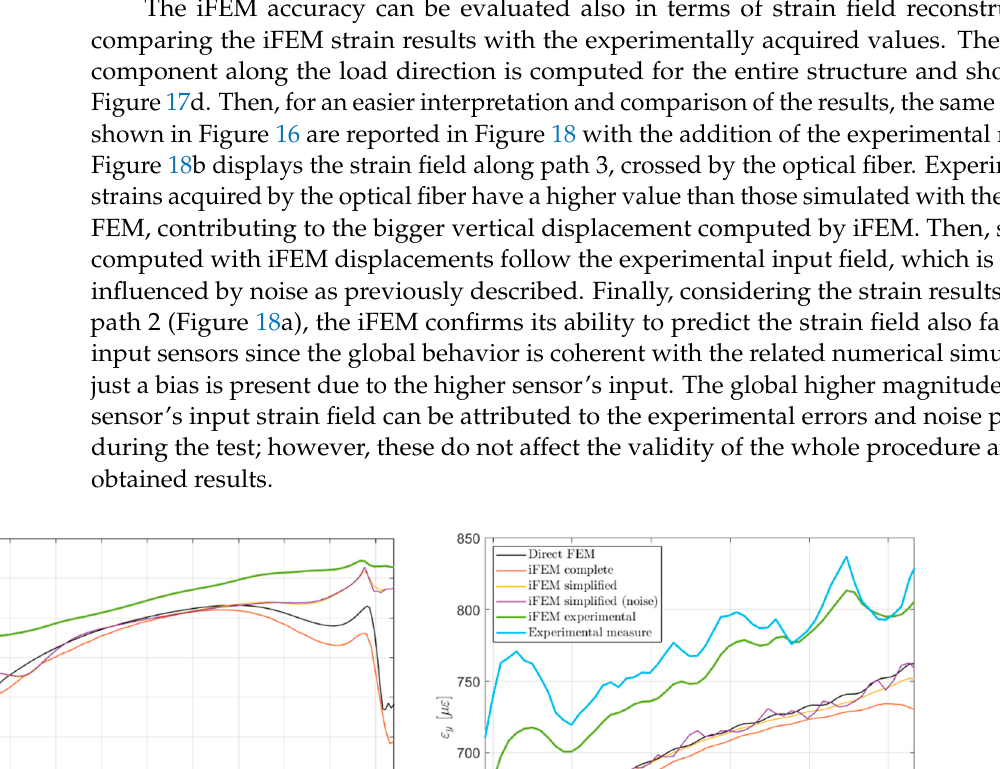
Figure 18. Vertical strain component ε y comparison on the top side of the structure with experimental results: ( a ) Path 2; ( b ) Path 3.